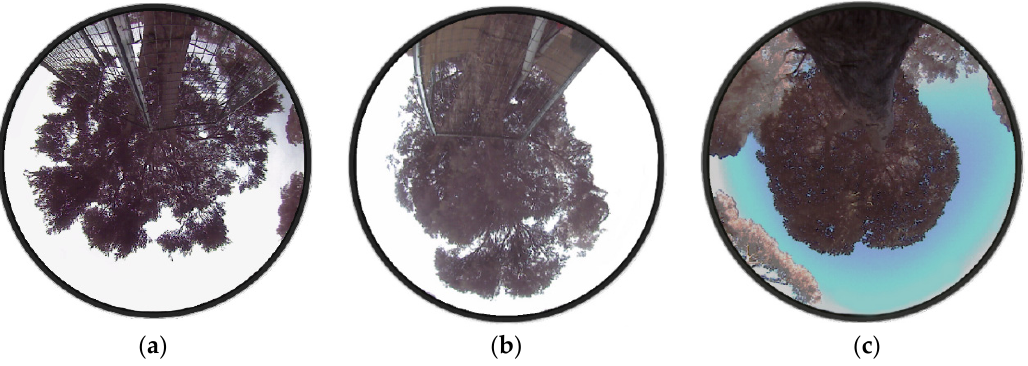
Figure 2. Canopy hemispherical photographs for each of the three species ( a ) C. maculata ( b ) M. styphelioides ( c ) L. confertus .